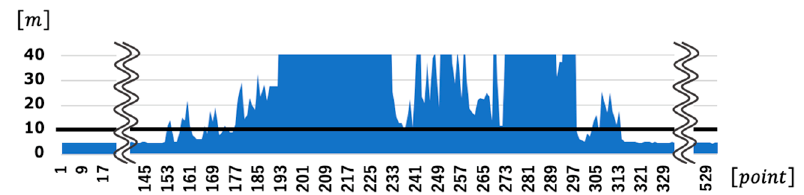
Figure 14. Examples of variations in the radius of certainty for the location as the horizontal GPS error while a user is staying indoors. (cid:1846)ℎ (cid:2869) (cid:3404) 10.0(cid:1865) is set as the threshold, and the graph does not display values higher than 40 (cid:1865) . The duration from the 151st to the 313rd point actually represents the situation of a user being indoors. However, several parts shift below the threshold (cid:1846)ℎ (cid:2869) even if a user is moving indoors.